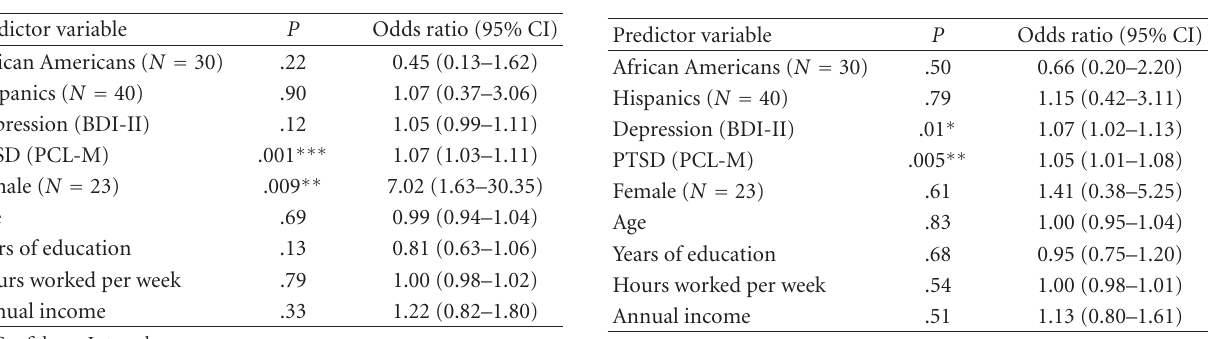
Table 3: Logistic regression predicting any specialty mental health treatment attendance.